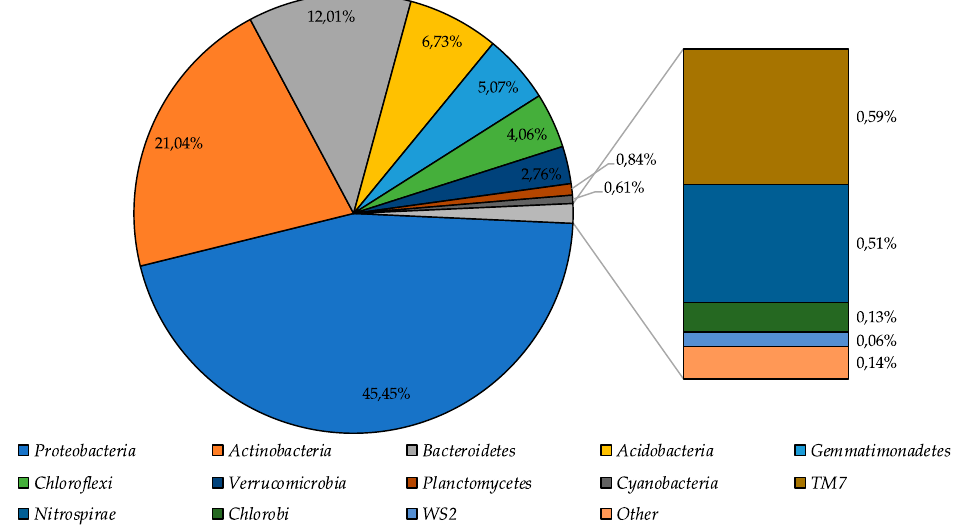
Figure 3. Index obtained was 1109.1; the Pielou index (evenness)—0.79, the Shannon index—7.99, the Simpson index—0.99. The shape of rarefaction curves (Figure S1) built for these indices indicates the high coverage of biodiversity of the sample analysed.